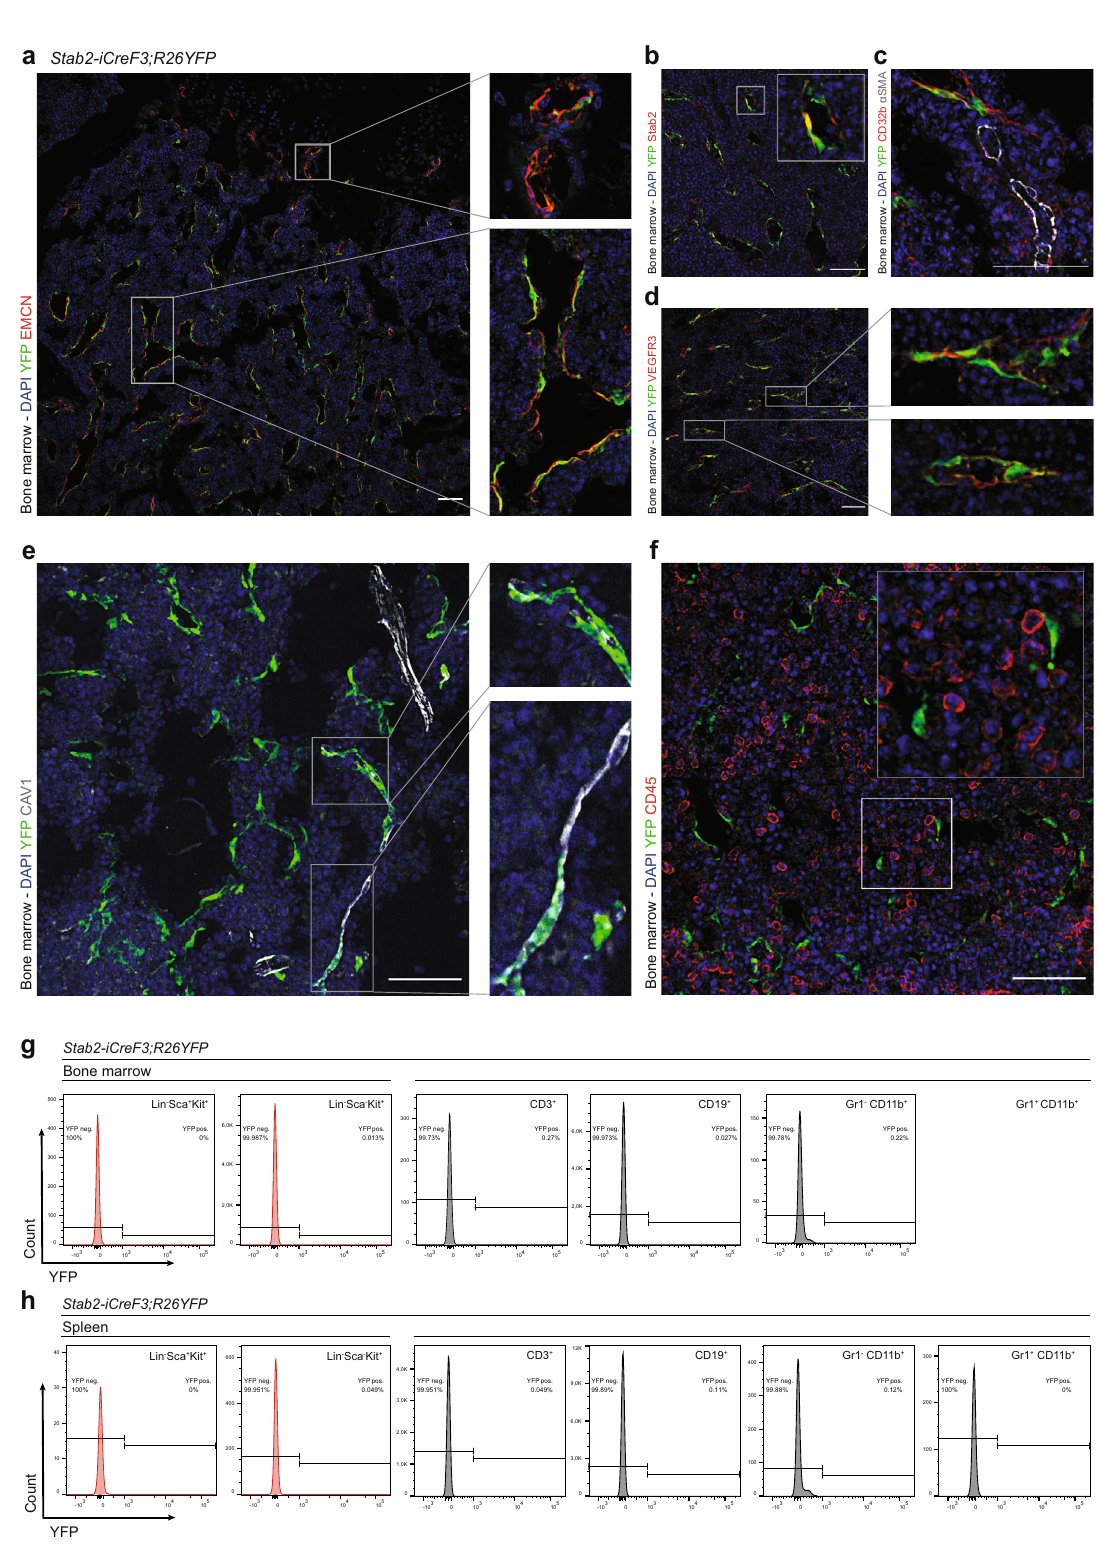
Fig. 1 Stab2-iCreF3;R26YFP mice show reporter activity restricted to sinusoidal endothelial cells in the bone marrow. a – c Immuno fl uorescence (IF) staining for endothelial markers of Stab2-iCreF3;R26YFP bone marrow from 6-month-old female mice. Co-IF of YFP, DAPI and a EMCN ( n = 3), b Stab2 ( n = 3), c CD32b, α -SMA ( n = 3), d VEGFR3, and e CAV1. Scale bars: 50 μ m. f – h Hematopoietic marker staining of Stab2-iCreF3;R26YFP bone marrow from